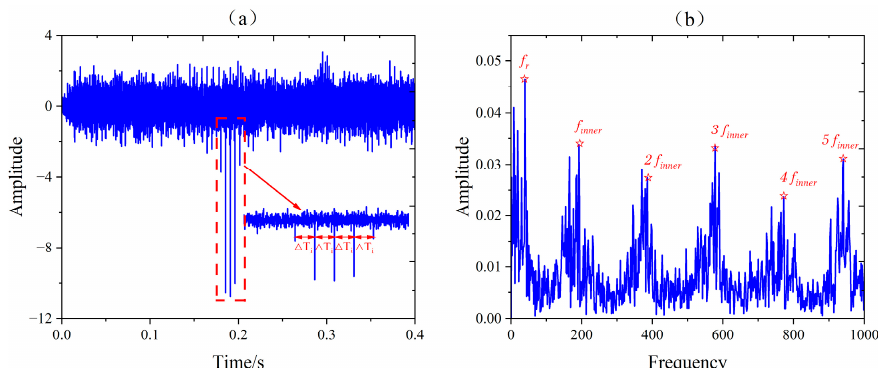
Figure 20. The outcomes produced by MDMVO-MCKD adaptively enhance the inner race fault pulse: ( a ) The best deconvoluted signal, and ( b ) its envelope spectrum.